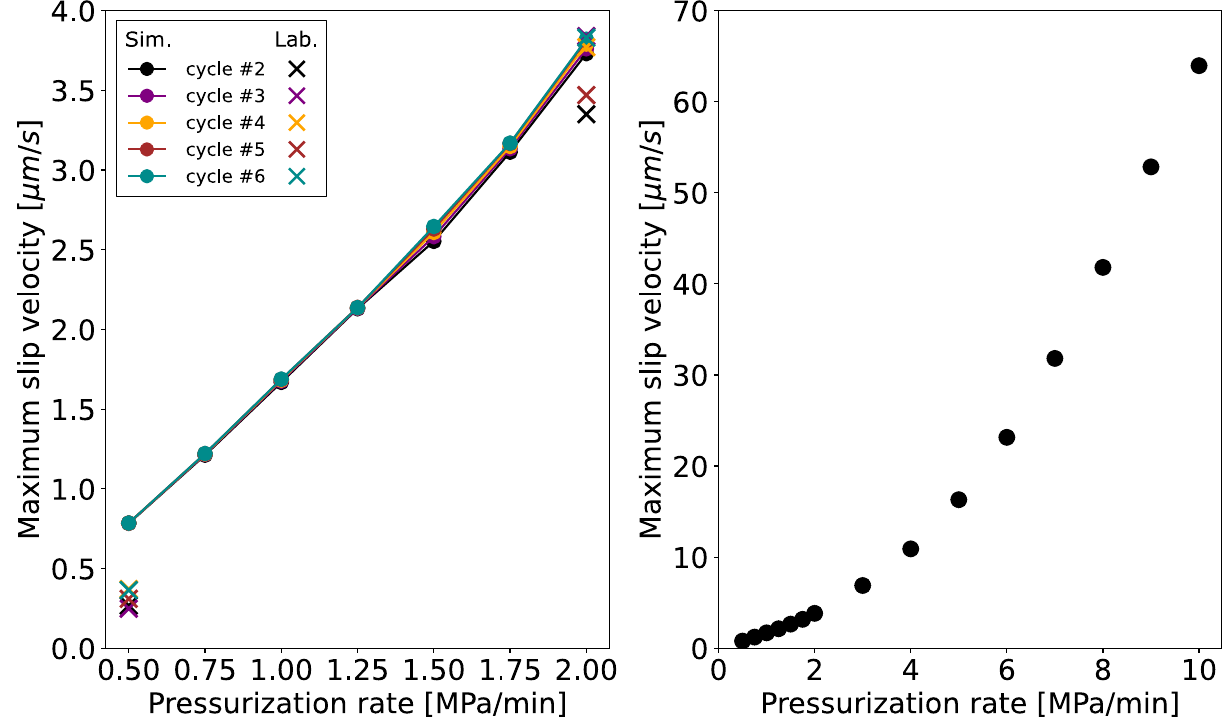
Figure 5. Computed maximum slip velocities versus pressurization rates (solid circles); ( a ) between 0.5 and 2 MPa/min for stimulation cycles 2 to 6. The first cycle was omitted due to its outlier values (fluid injection stopped shortly after the onset of fault reactivation); ( b ) for fluid pressurization rates ranging from 0.5 to 10 MPa/min. Laboratory values are denoted by crosses at 0.5 MPa/min and 2